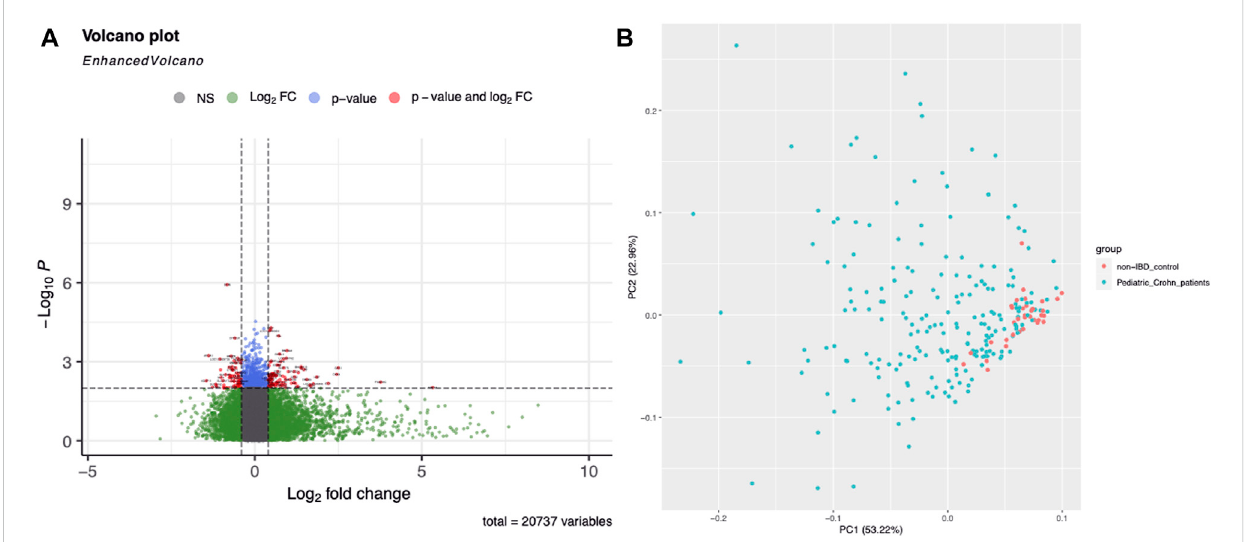
FIGURE 1 Differential gene expression in Pediatric Crohn ’ s Disease and controls. (A) Enhanced volcano plot showing the log2 fold change and -log10 p -value foreachgeneinthedataset.Geneswithasigni fi cantdifferenceinexpression( p < 0.05)arehighlightedinred,withthoseshowinganincreasedexpression inPediatric Crohn ’ sDisease inblue and decreased expressioningreen. (B) Principal component analysis (PCA) plotillustrating theseparation ofPediatric Crohn ’ s Disease and control samples based on gene expression levels. Each point represents a sample, with Pediatric Crohn ’ s Disease samples shown in red and controls in blue. The fi rst two principal components (PC1 and PC2) are plotted, representing the majority of the variation in the